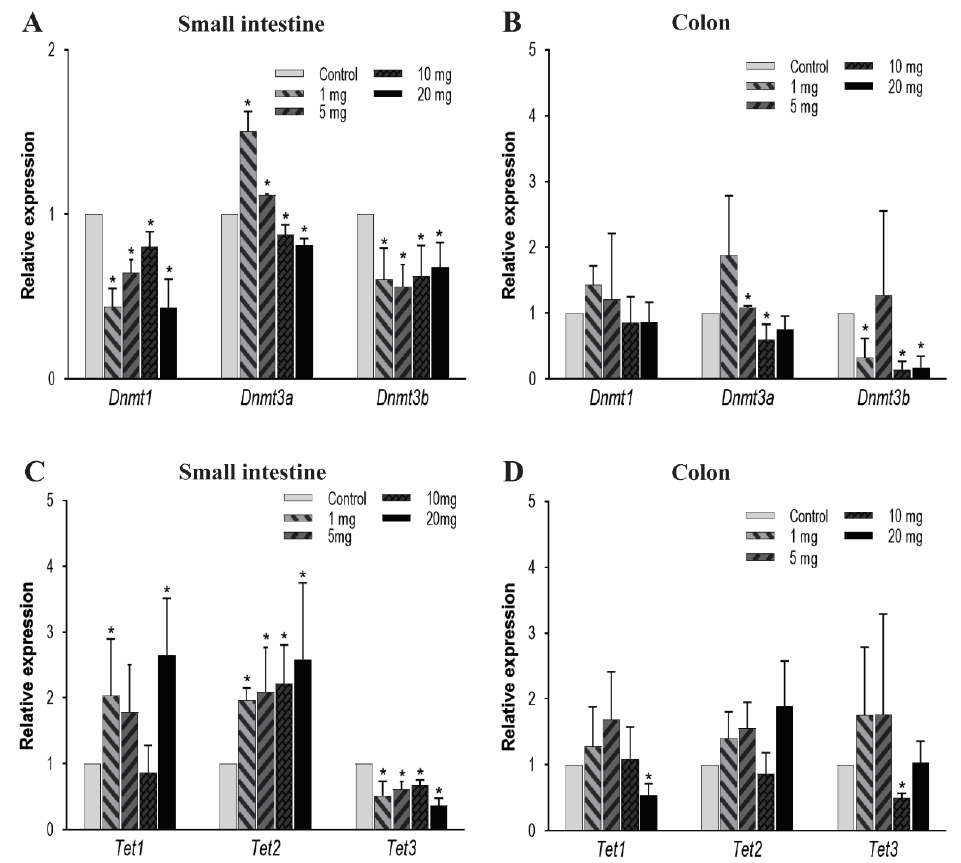
Figure 2. E ff ect of PFOA on the expression levels of DNA methylation ( Dnmts ) and DNA demethylating genes ( Tets ) in intestinal tissues of CD1 mice. Mice were treated with control (0.5% Tween-20 in water) or 1–20 mg / kg / day PFOA for 10 days. ( A ) Change in the mRNA expression level of Dnmt1 , Dnmt3a and Dnmt3b genes in the small intestine; ( B ) change in the mRNA expression level of Dnmt1 , Dnmt3a and Dnmt3b genes in the colon; ( C ) change in the mRNA expression level of Tet1 , Tet2 and Tet3 genes in the small intestine; ( D ) change in the mRNA expression level of Tet1 , Tet2 and Tet3 genes in the colon. Statistical values were considered significant at p -value ≤ 0.05 (denoted by “*”) and less significant at p -value >